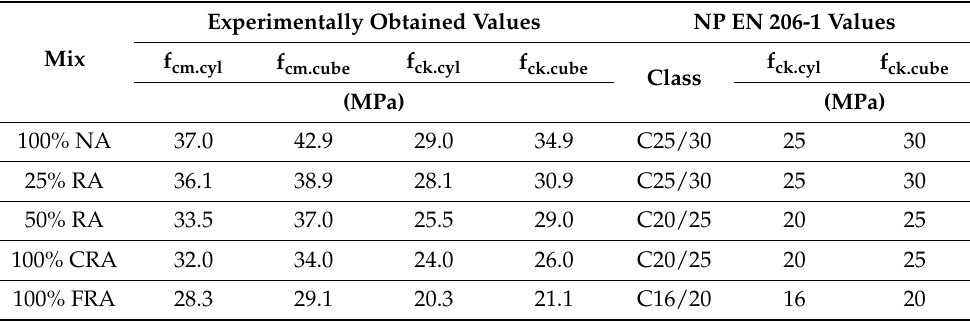
Table 7. Compressive strength classes determined according to NP EN 206-1 [31] (PC